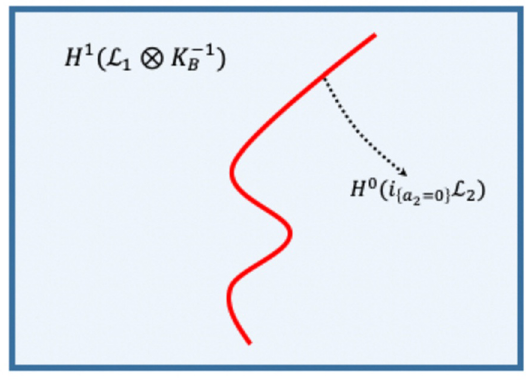
Figure 4 . Some of 27 matter in the effective theory are from the bulk zero modes, and some of them are zero modes on the intersection of the 7-branes (red curve).